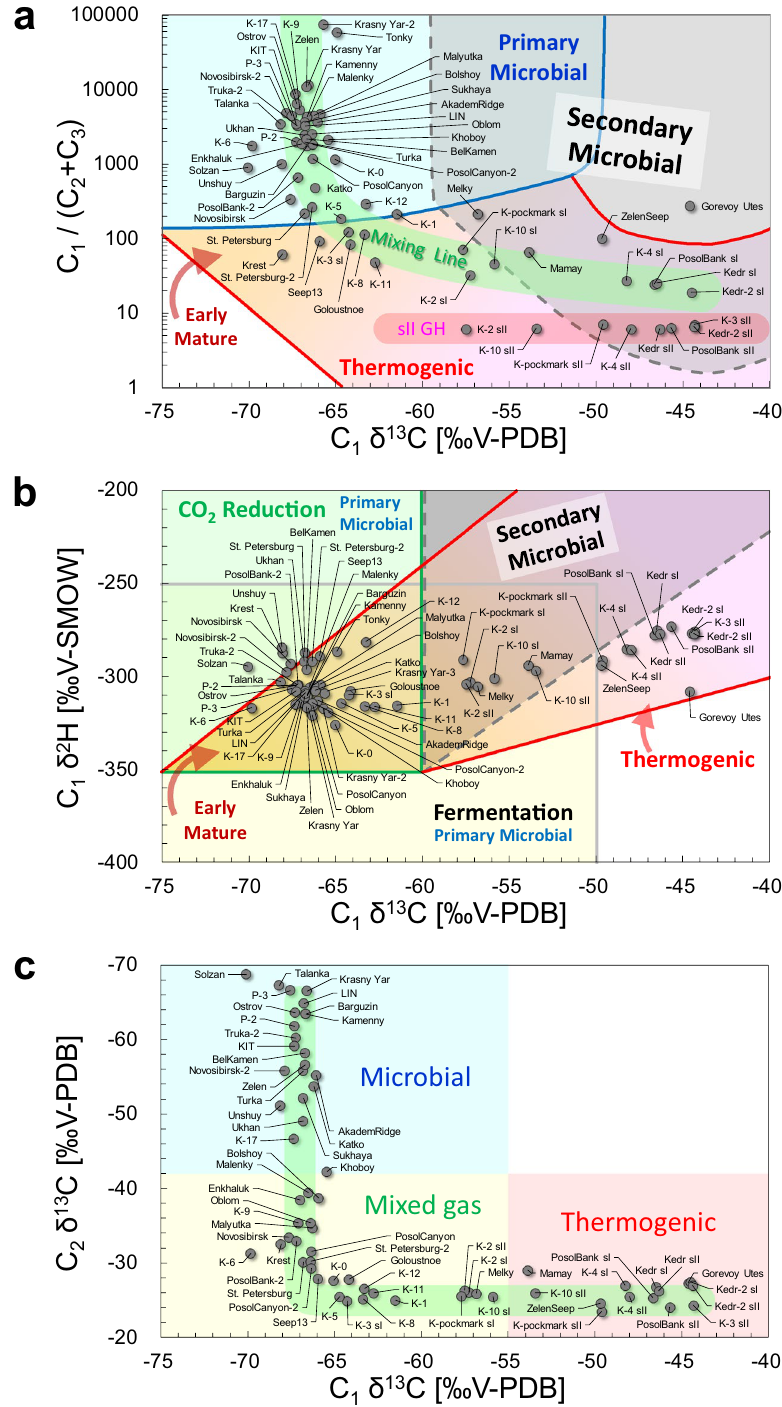
Figure 2. Empirical diagrams of hydrate-bound gases. ( a ) C 1 /(C 2 + C 3 ) plotted against C 1 δ 13 C, based on the classification of Milkov and Etiope 13 ; ( b ) C 1 δ 2 H plotted against C 1 δ 13 C, based on the classification of Milkov and Etiope 13 ; and ( c ) C 2 δ 13 C plotted against C 1 δ 13 C, based on the classification of Milkov 15 . The data for Malenky, Bolshoy, Malyutka, P-2, K-0, K-2 and Goloustnoe are sourced partly from Hachikubo et al. 33 . The data for Kedr and Kedr-2 are sourced partly from Hachikubo et al. 41